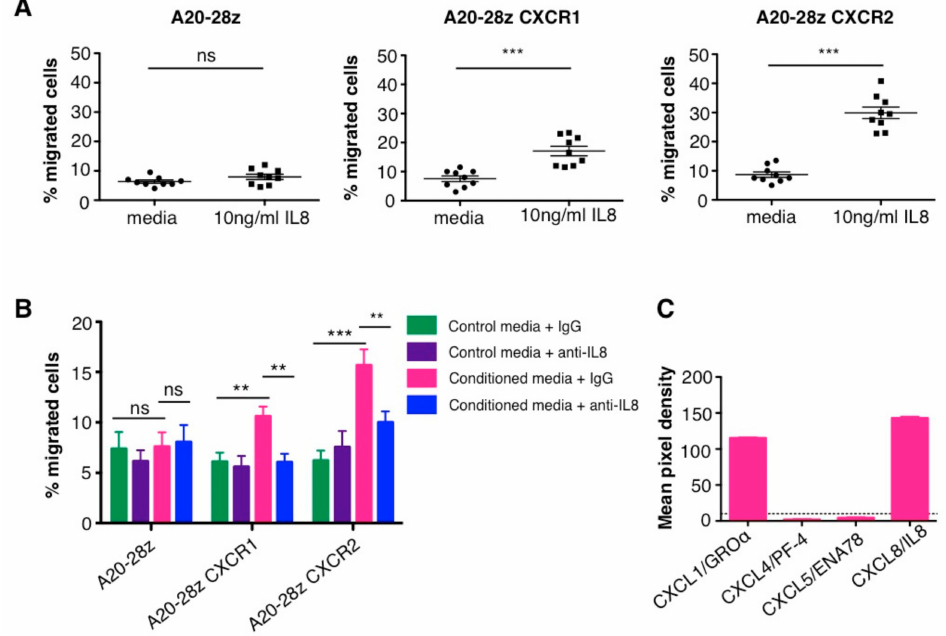
Figure 4. In vitro migration of chemokine receptor CAR T-cells to IL-8. ( A ) Media or media containing 10 ng / mL recombinant human IL-8 was added to the lower well of a transwell migration plate. CAR T-cells were added to the upper chamber and the percentage of migrated T-cells in the lower well was quantified after 2 h. Data show the percentage of migrated cells in triplicate wells from 3 independent experiments (mean ± SEM); *** p < 0.0001, calculated using Student’s t -test. ( B ) Conditioned media from SKOV3 cells that contained either an IgG control or an anti-IL-8 blocking antibody was added to the lower well of a transwell migration plate. CAR T-cells were added to the upper chamber and the percentage of migrated T-cells in the lower well was quantified after 2 h. Data show the percentage of migrated cells within triplicate wells from 3 independent experiments (mean ± SEM); ns: not significant; ** p < 0.01; *** p = 0.0001 calculated using an unpaired, two-tailed Student’s t -test. ( C ) Secretion of CXCL1 and IL-8 (CXCL8) by SKOV3 cells. Supernatant from SKOV3 was applied to nitrocellulose membranes spotted with capture antibodies and then detected using biotinylated antibodies followed by chemiluminescent detection reagents. Mean pixel density from duplicate wells was calculated using Image J